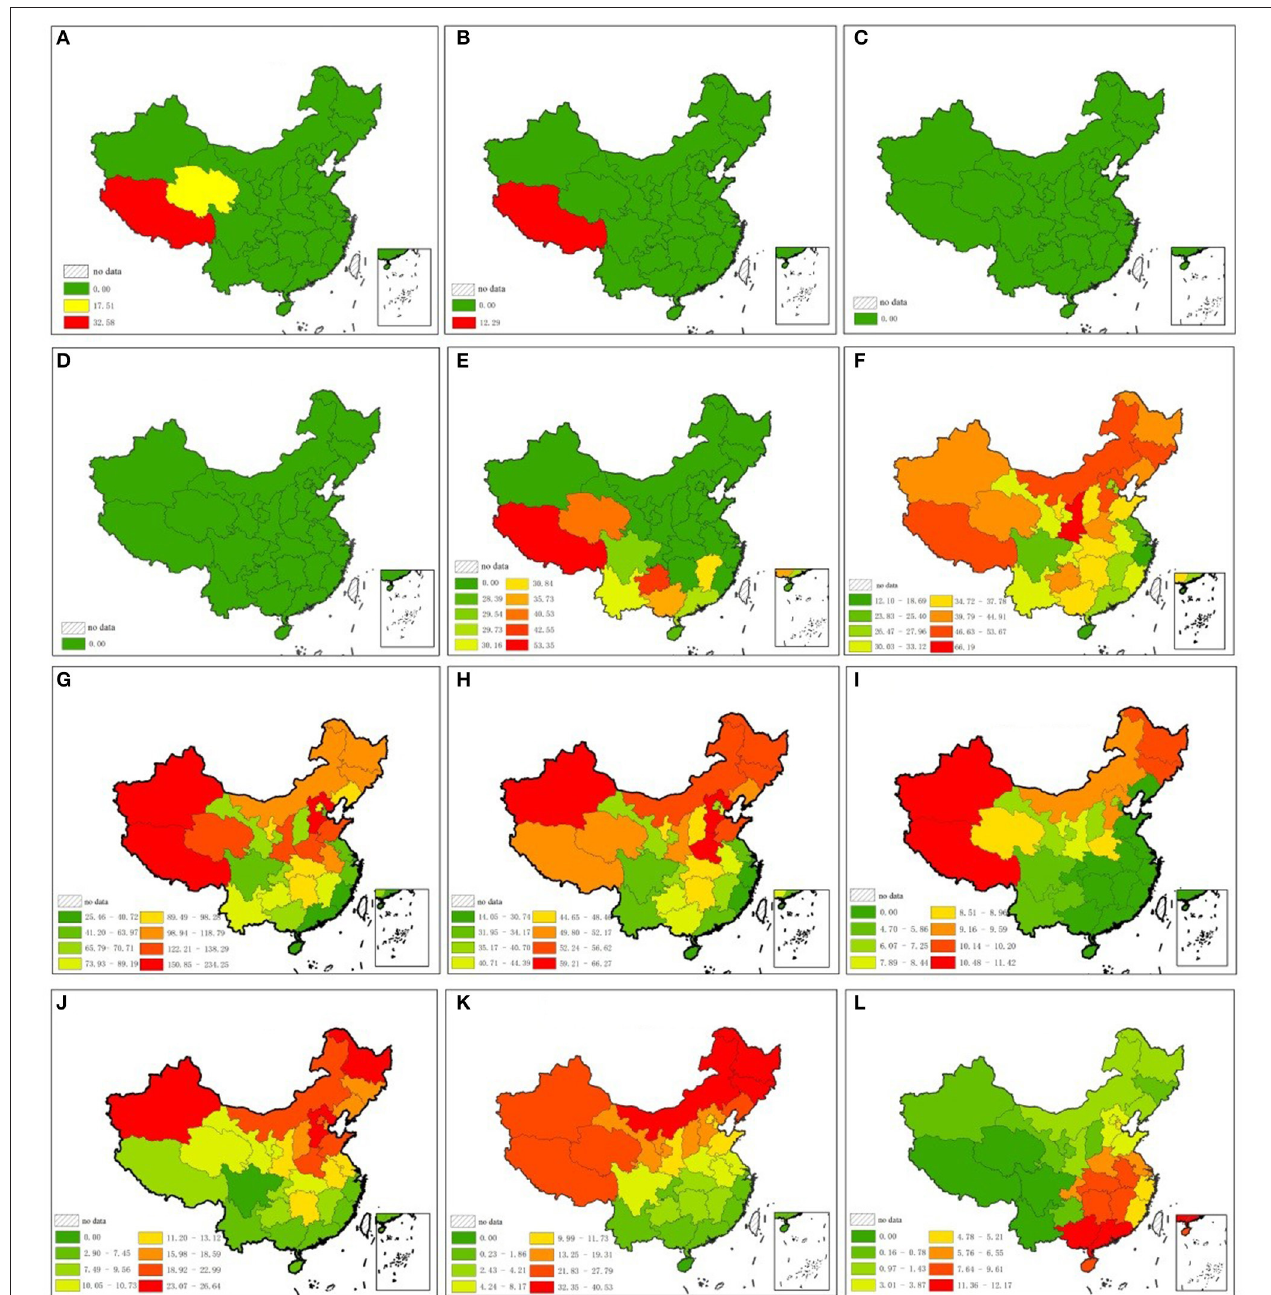
FIGURE 6 | Attributable proportion of 12 risk factors for CVD in each province. (A) Vegetables and edible fungi intake (kg/per capita per year). (B) Nuts and seeds intake (kg/per capita per year). (C) Whole grain intake (kg/per capita per year). (D) Fibre intake (kg/per capita per year). (E) Fruits intake (kg/per capita per year). (F) Tobacco sales (cigarettes/per capita per year). (G) Salt intake (g/per capita per year). (H) PM 2.5 ( µ g/m 3 ). (I) Seafood intake (kg/per capita per year). (J) Obesity and overweight rate. (K) Yearly number of days for each low temperature range. (L) Yearly number of days for each high temperature